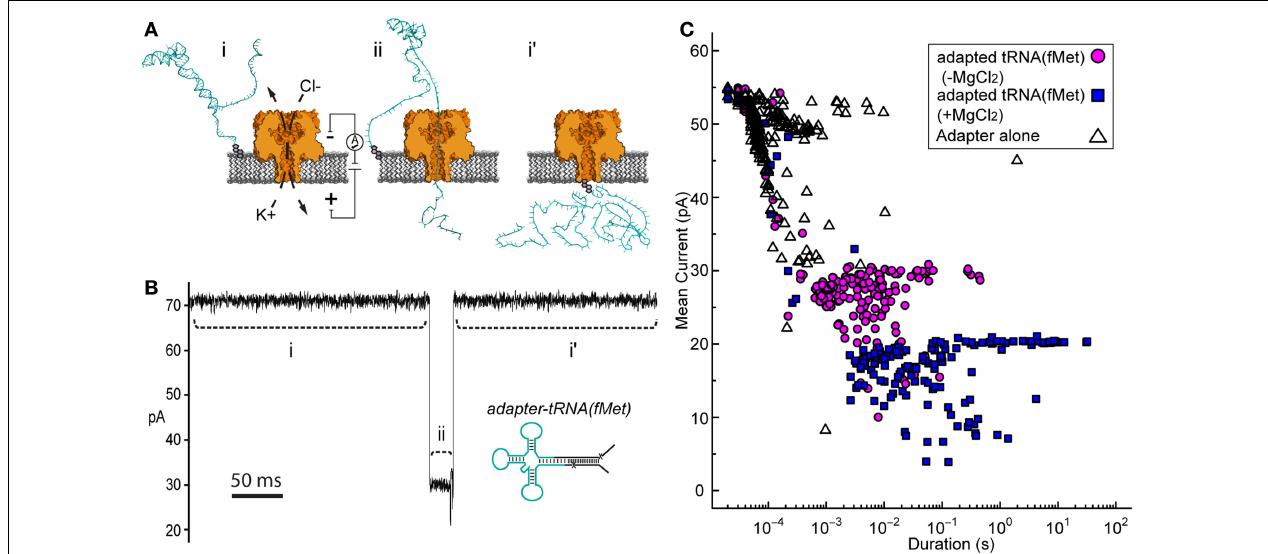
FIGURE 2 | Adapted tRNA-dependent ionic current blockades observed during single-channel α -HL nanopore experiments